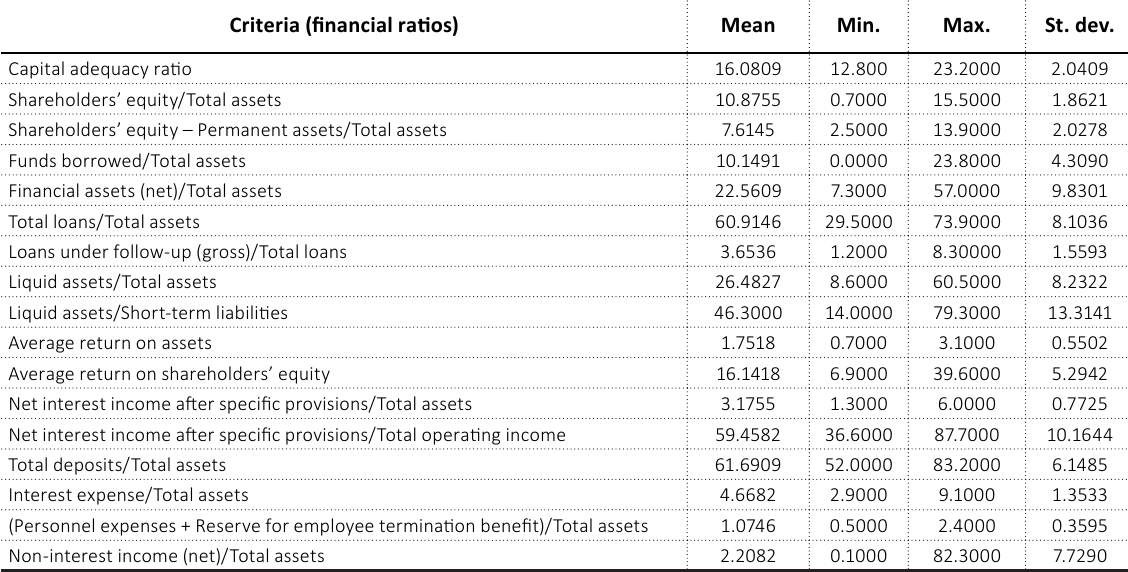
Table 3. Descriptive statistics of financial ratios